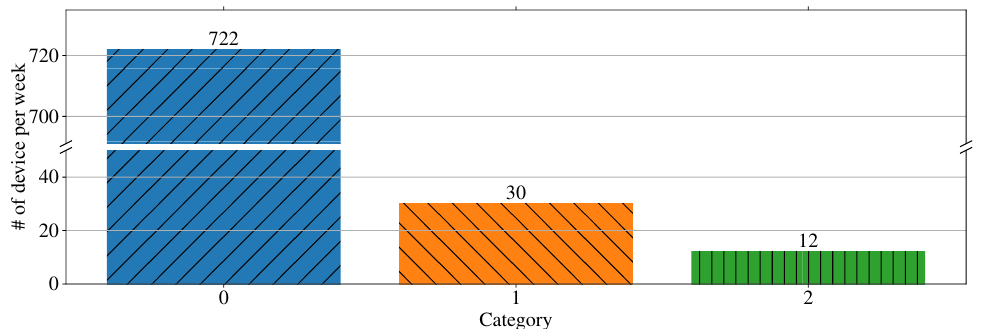
Figure 19. Number of device per week on cyclical component clustering.